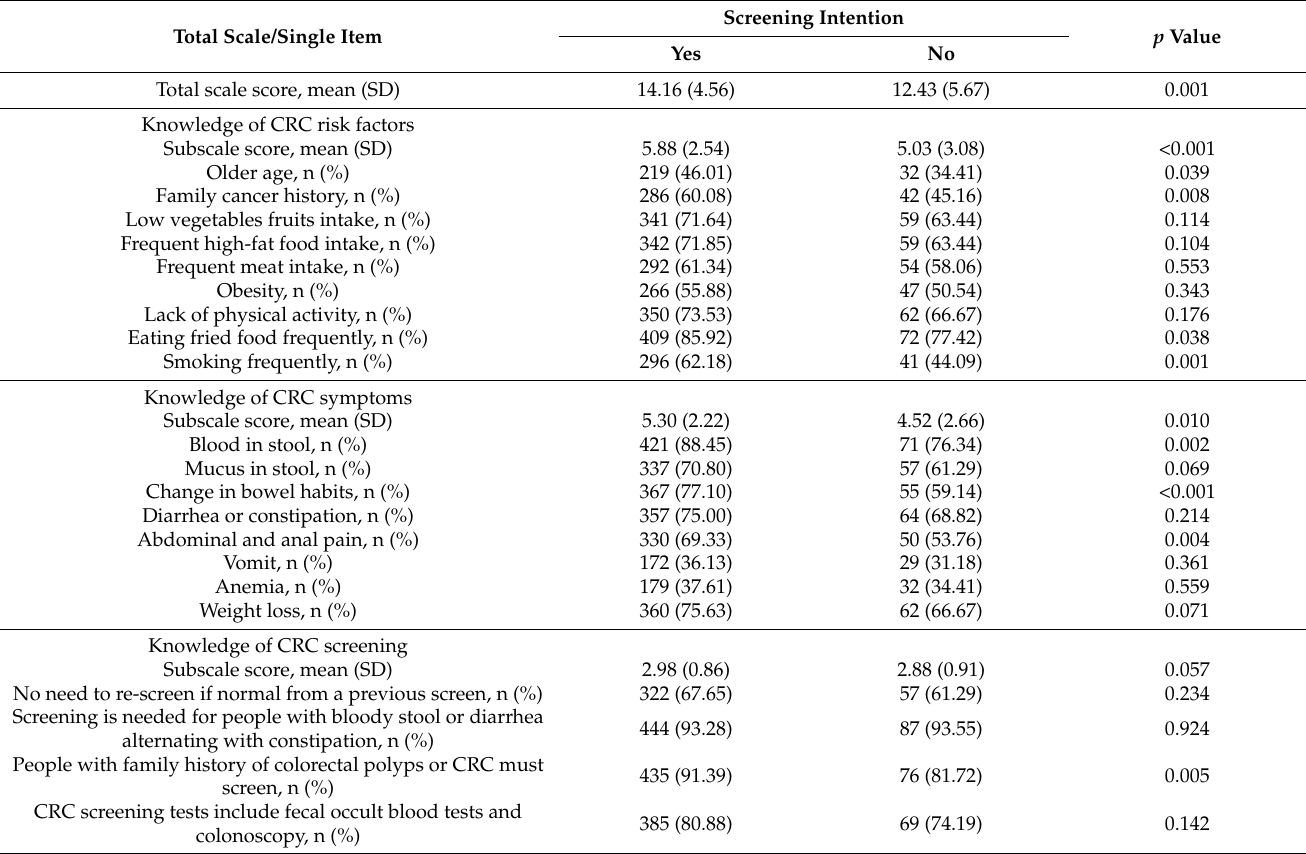
Table 2. Comparisons of knowledge of CRC among urban residents with and without colorectal cancer screening